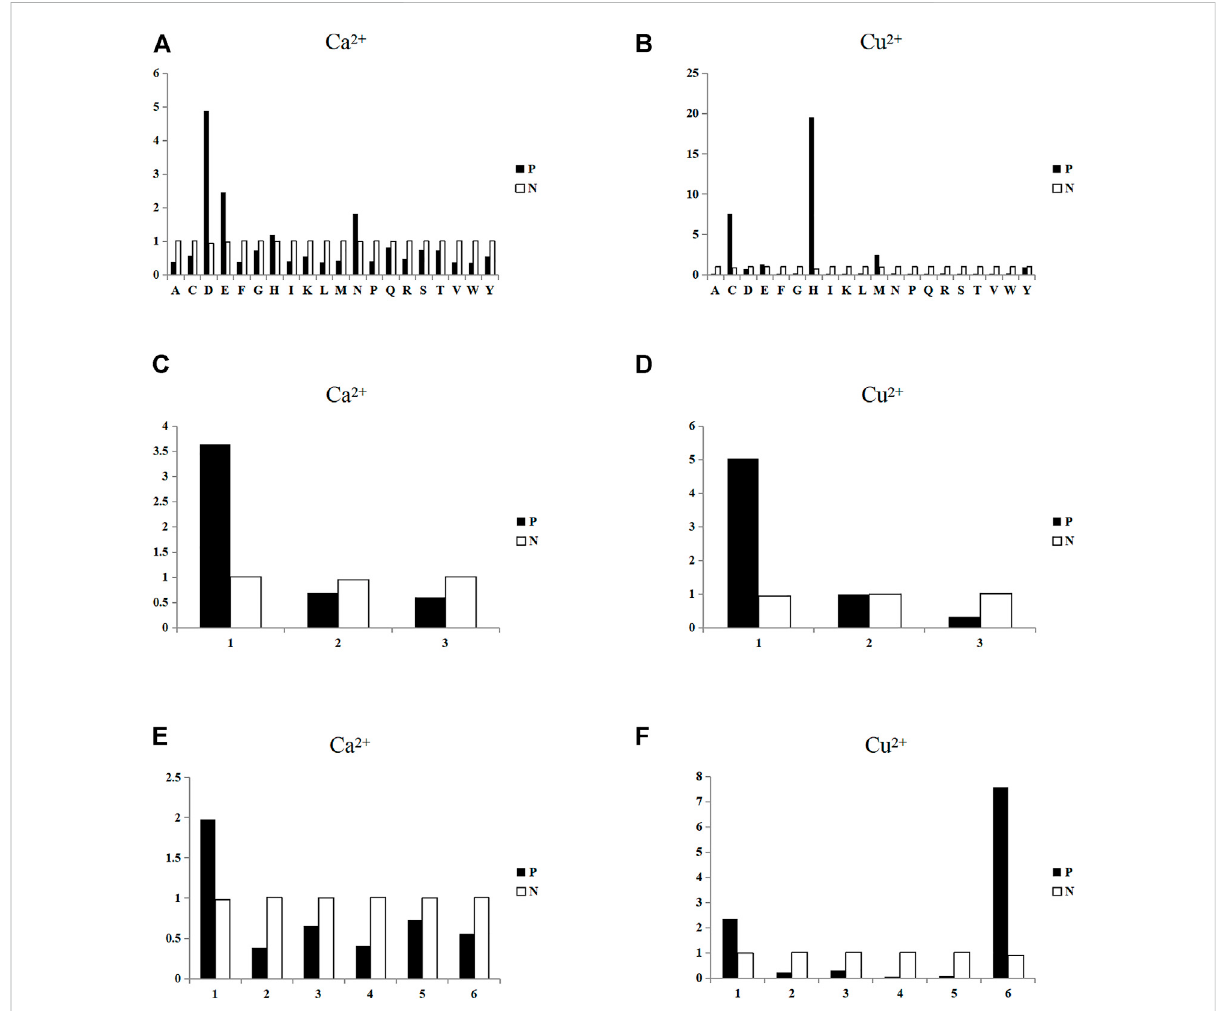
FIGURE 3 Statisticalanalysisofthepropensityfactorsofbindingresiduesandnon-bindingresidues.Note: InFigure3,theordinaterepresents thevalueof propensity factors, and P and N represent binding residues and non-binding residues, respectively. Figures (A) and (B) are the statistical analysis of propensityfactorsofaminoacidsofCa 2+ andCu 2+ ligands,respectively;Theabscissarepresents20aminoacids.Figures (C) and (D) arethestatistical analysis of propensity factors of charge features of Ca 2+ and Cu 2+ ligands, respectively; and the abscissa represents the three charge classi fi cations. Figures (E) and (F) are the statistical analysis of the propensity factors of hydrophilic-hydrophobic features of Ca 2+ and Cu 2+ ligands, respectively; and the abscissa represents the six hydrophilic-hydrophobic classi fi